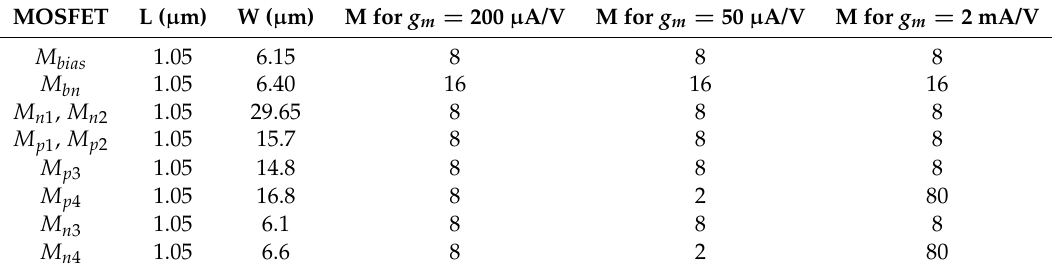
Table 2. Sizes of the OTA with different multiplicity (M) for the g m centered at 200 µ A/V, 50 µ A/V and 2